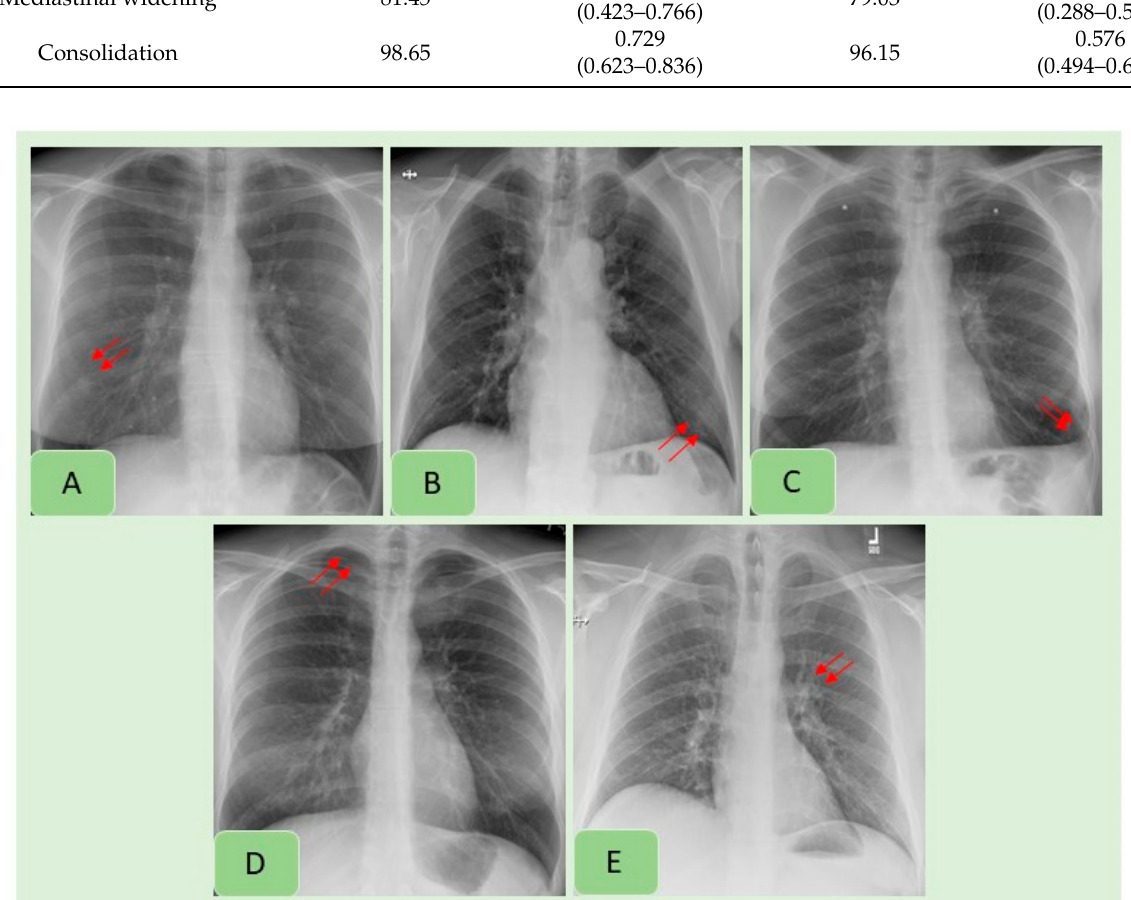
Figure 4. Examples of CXR findings missed by both the AI algorithm and in the original radiology reports: pulmonary nodule ( A ), consolidation ( B ), pleural effusion ( C ), pneumothorax ( D ) and hilar prominence ( E ).